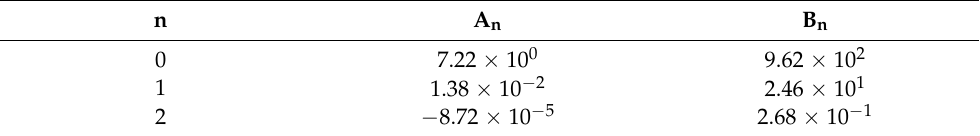
Table A53. Coefficients of the CH 3 OH-LiI + ZnBr 2 saturated pressure equation.